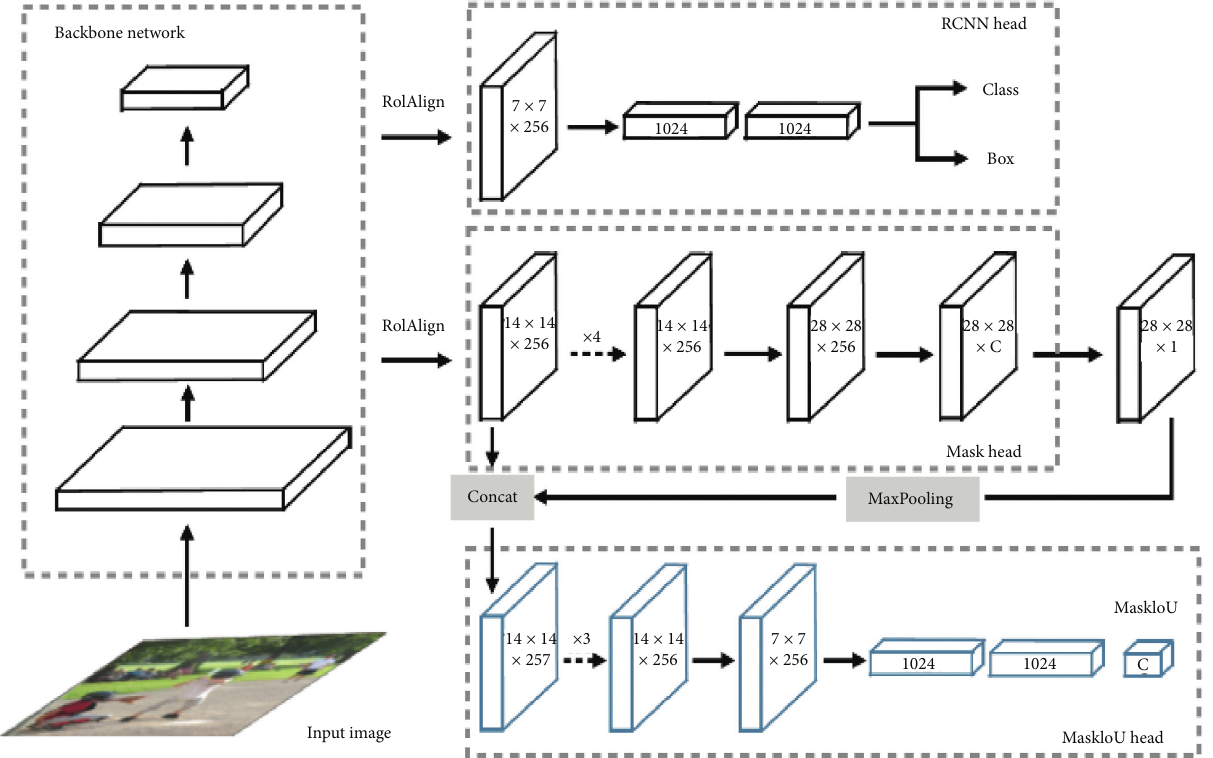
Figure 3: The network framework of Mask Scoring RCNN